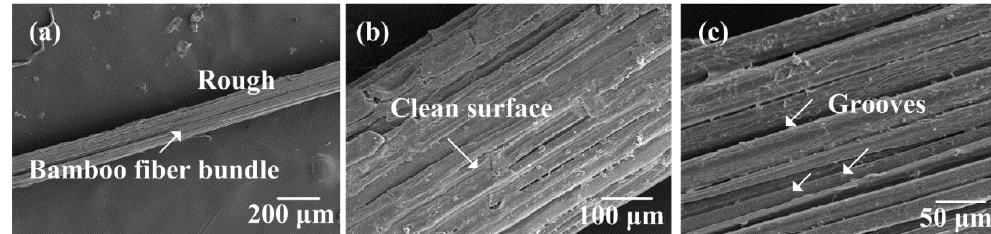
Figure 6. SEM images of the surface of the 6 wt.% NaOH-treated bamboo fiber bundles.